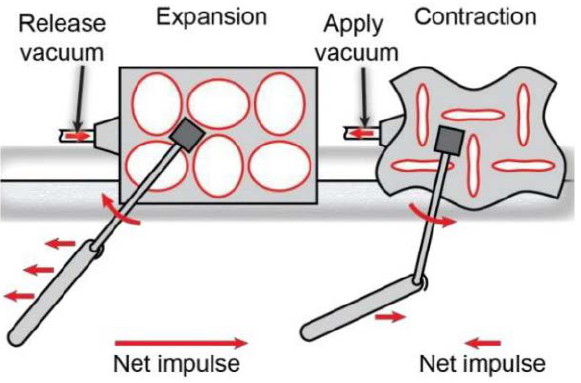
Figure 10. One example of biomimetic gait design [76], reproduced with permission from [76], 2015, John Wiley and Sons.